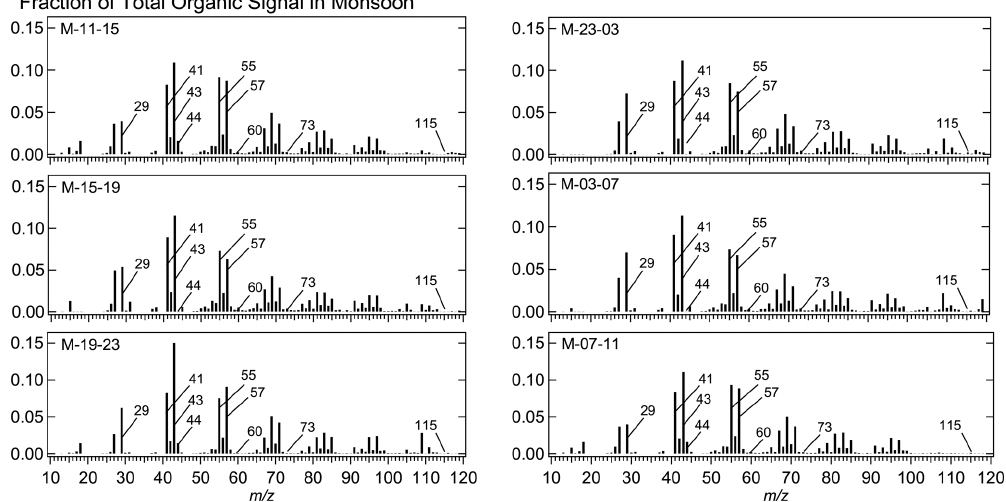
Figure 8. The mass spectrum of time-of-day PMF hydrocarbon-like organic aerosol (HOA) factor in the 2017 monsoon season. The mass spectra remain fairly consistent across the time-of-day periods.